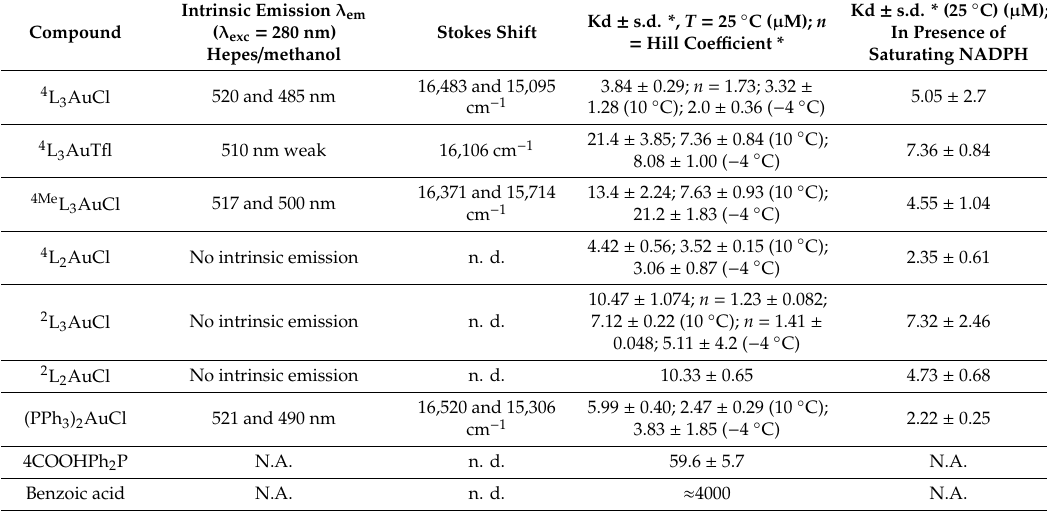
Table 2. List of fluorescence data for the gold(I) compounds once treated with DHFR (DiHydroFolate Reductase) and DHFR / NADPH (Nicotinamide Adenine Dinucleotide Phosphate), with the corresponding Kd